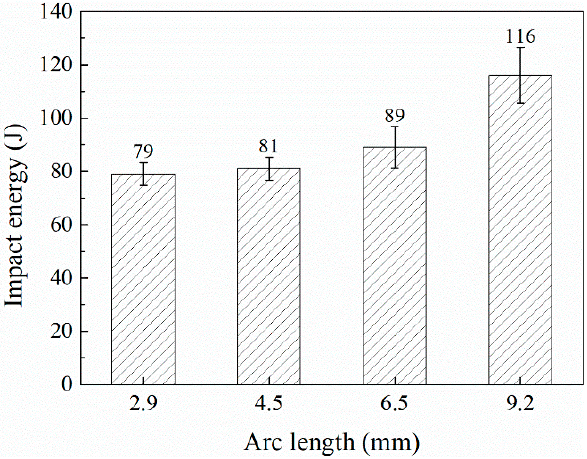
Figure 7. − 40 °C impact energy of weld metal under di ff erent arc lengths.